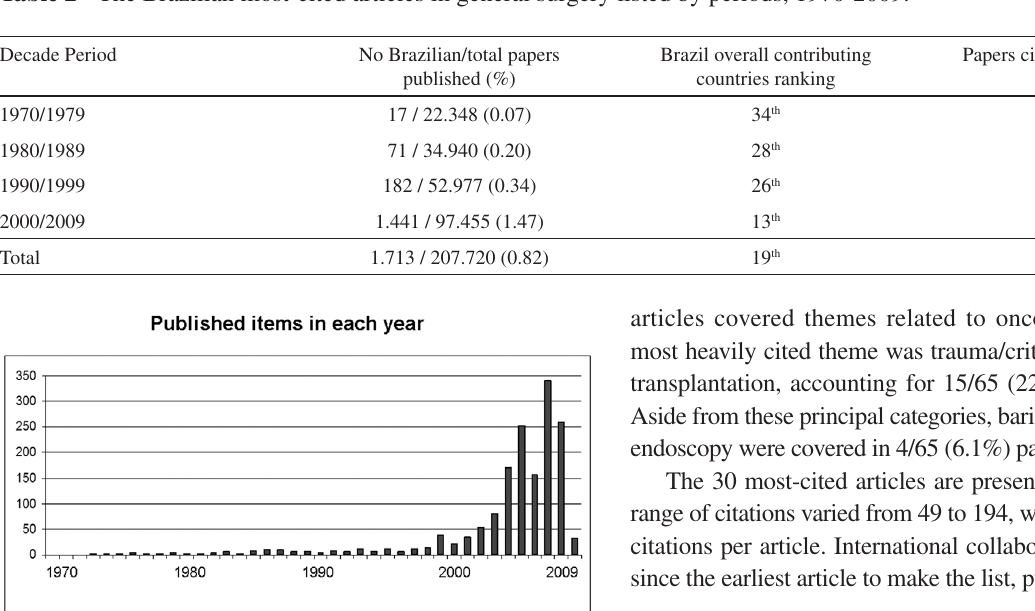
Table 2 - The Brazilian most-cited articles in general surgery listed by periods, 1970-2009.